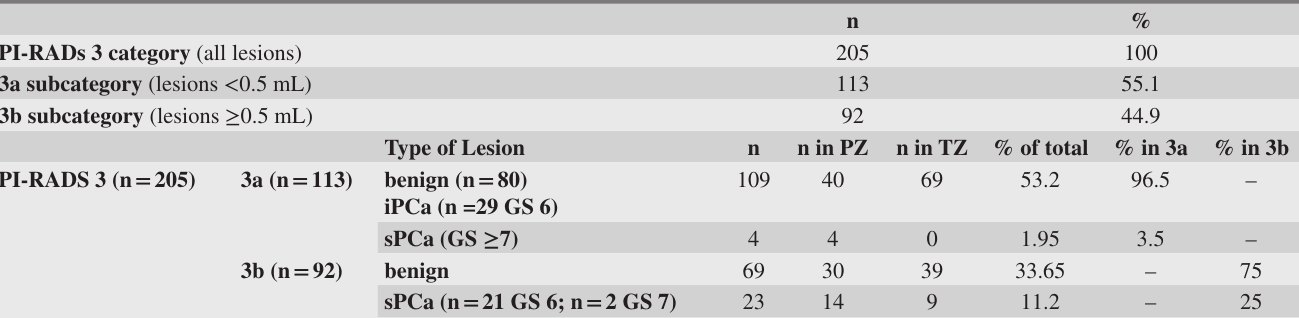
Table 1. Summary of Findings on PI-RADS 3 Category and PI-RADS 3a and 3b Subcategories PI-RADs 3 category (all